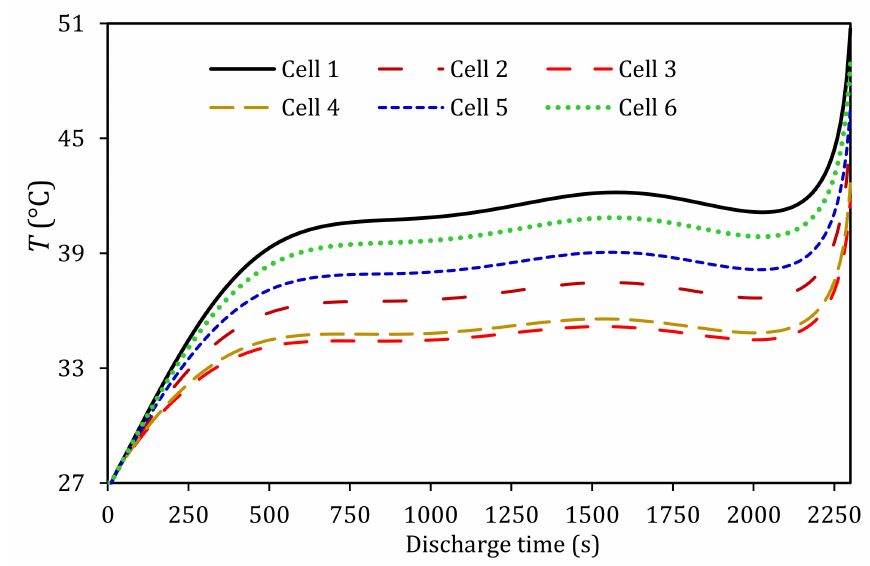
Figure 9. LIB cells temperature characteristic at 3C discharge rate with